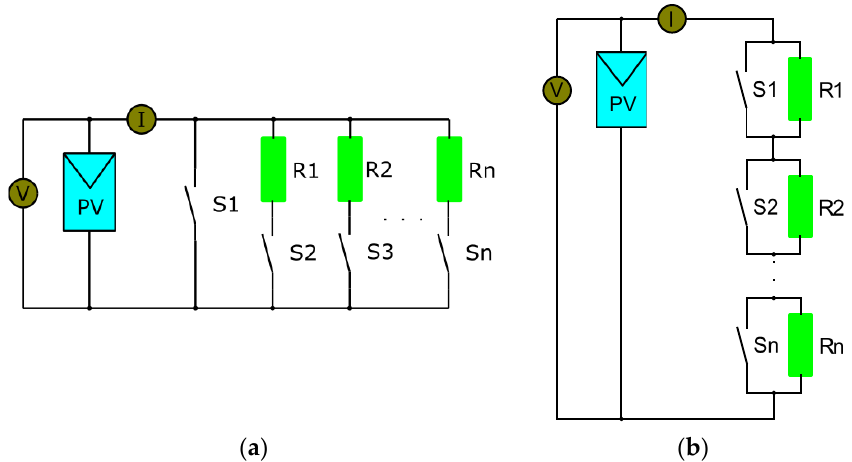
Figure 7. Variable Resistor Tracer Scheme: ( a ) Conventional Scheme; ( b ) Binary Tracer Scheme. Source [23], own elaboration.